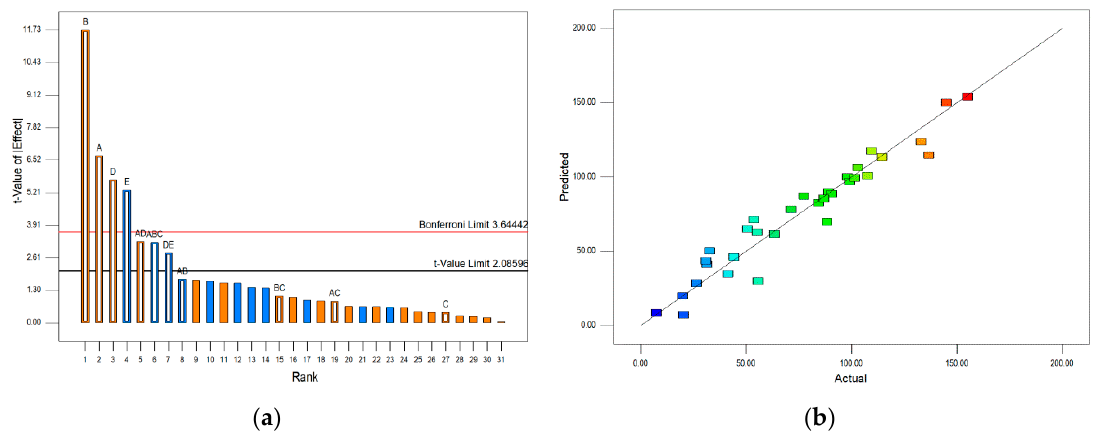
Figure 3. Cichoric acid content model: ( a ) Pareto chart; ( b ) actual vs. predicted results. Independent variables: A = glycerol concentration; B = temperature; C = ultrasound power; D = time; E = ascorbic acid concentration. Blue color on the chart ( a ) indicates a negative and the orange color refers to a positive effect of independent variables. The color points on the chart ( b ) represent the value of cichoric acid (blue: lowest value; red: highest value).